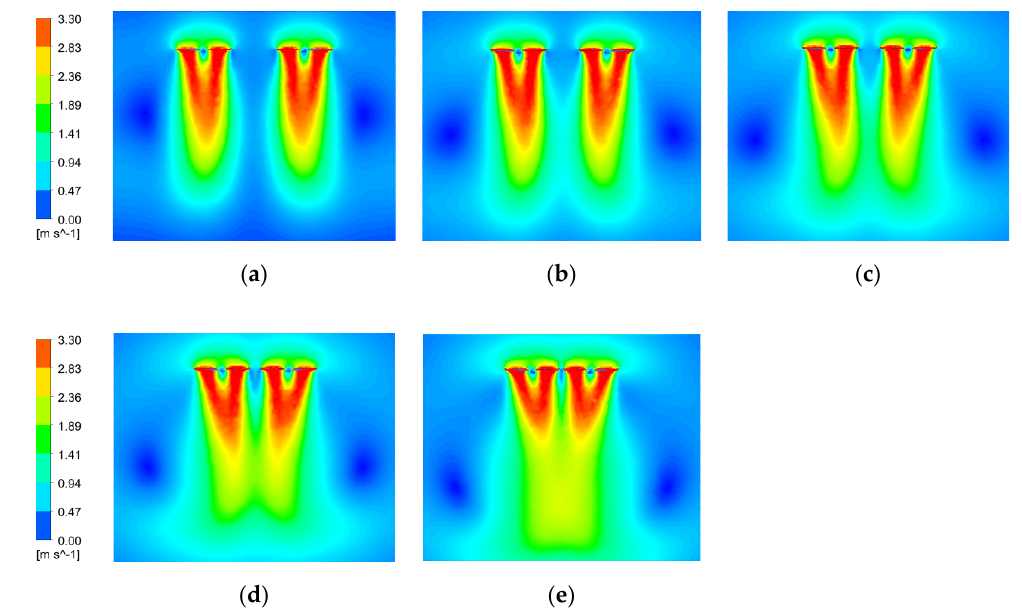
Figure 8. Comparison between experimental and simulation results.